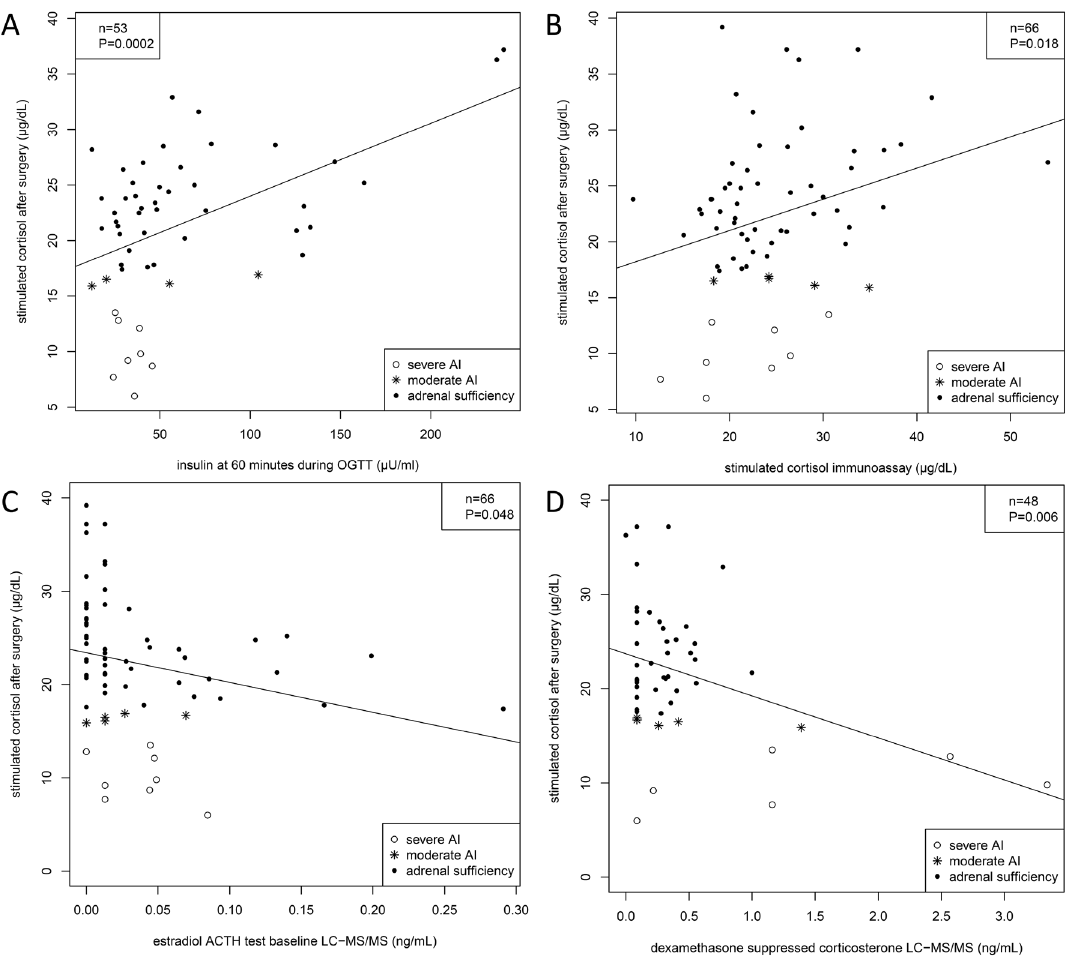
Figure 1. Single variables correlating with post-operative stimulated cortisol. Pre-operative insulin at 60 min during oral glucose tolerance test (OGTT) is positively correlated with post-operative stimulated cortisol ( A